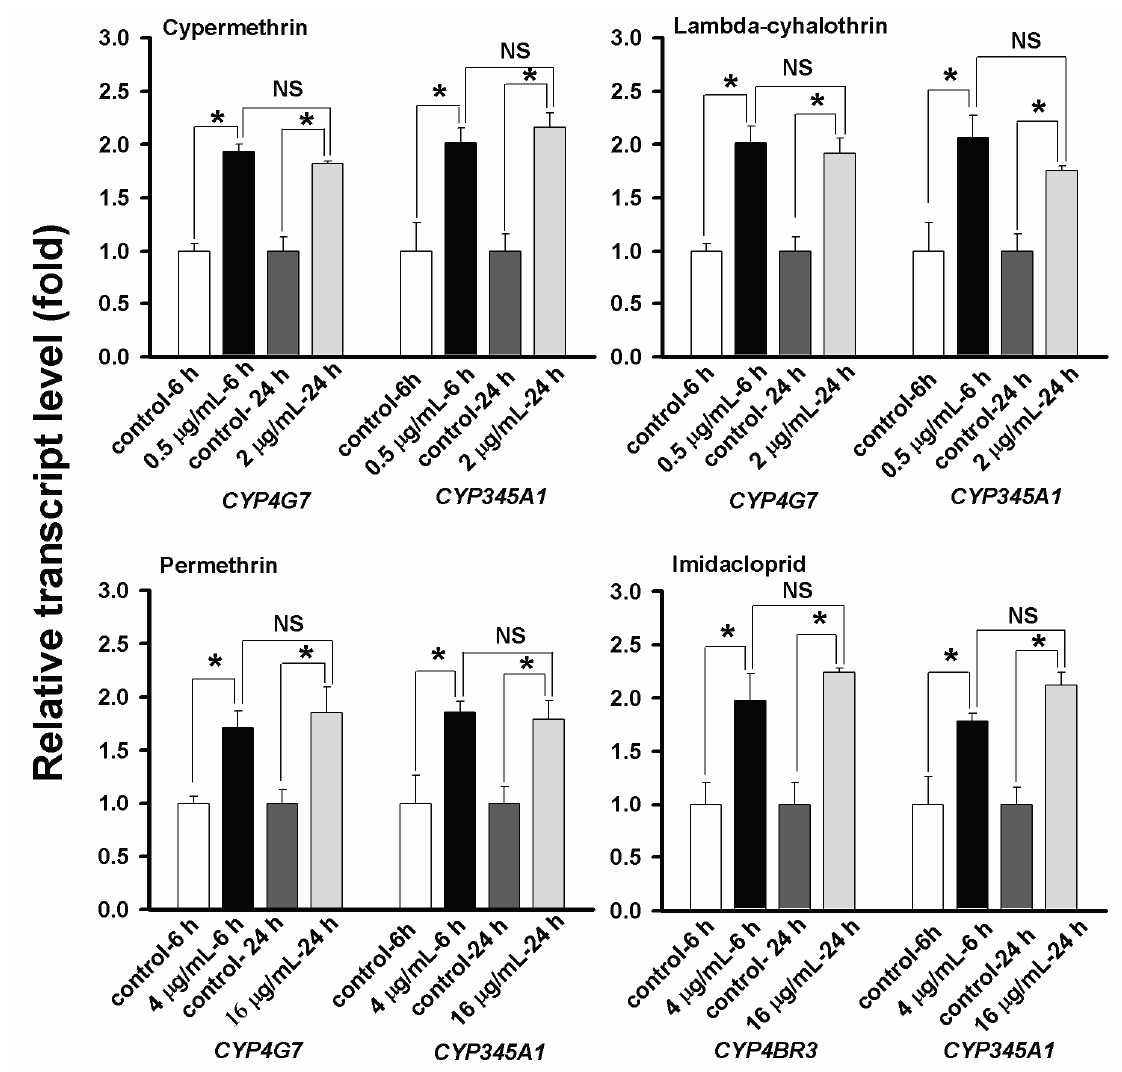
exposure times ( i.e ., 12, 24 and 48 h) and higher concentration of the insecticide ( i.e ., 2 μ g/mL), we compared the up-regulation of the three genes between the exposure times ( i.e ., 6 and 24 h) and between two insecticide concentrations ( i.e ., 2 and 0.5 μ g/mL for cypermethrin and lambda-cyhalothrin, and 16 and 4 μ g/mL for permethrin and imidacloprid). As shown in Figure 5, all the exposures resulted in significant up-regulations of the CYP genes as compared with their corresponding controls. There were no statistical differences between the exposures at 0.5 μ g/mL for 6 h and at 2 μ g/mL for 24 h for cypermethrin and lambda-cyhalothrin, and between the exposures at 4 μ g/mL for 6 h and at 16 μ g/mL for 24 h for permethrin and imidacloprid.